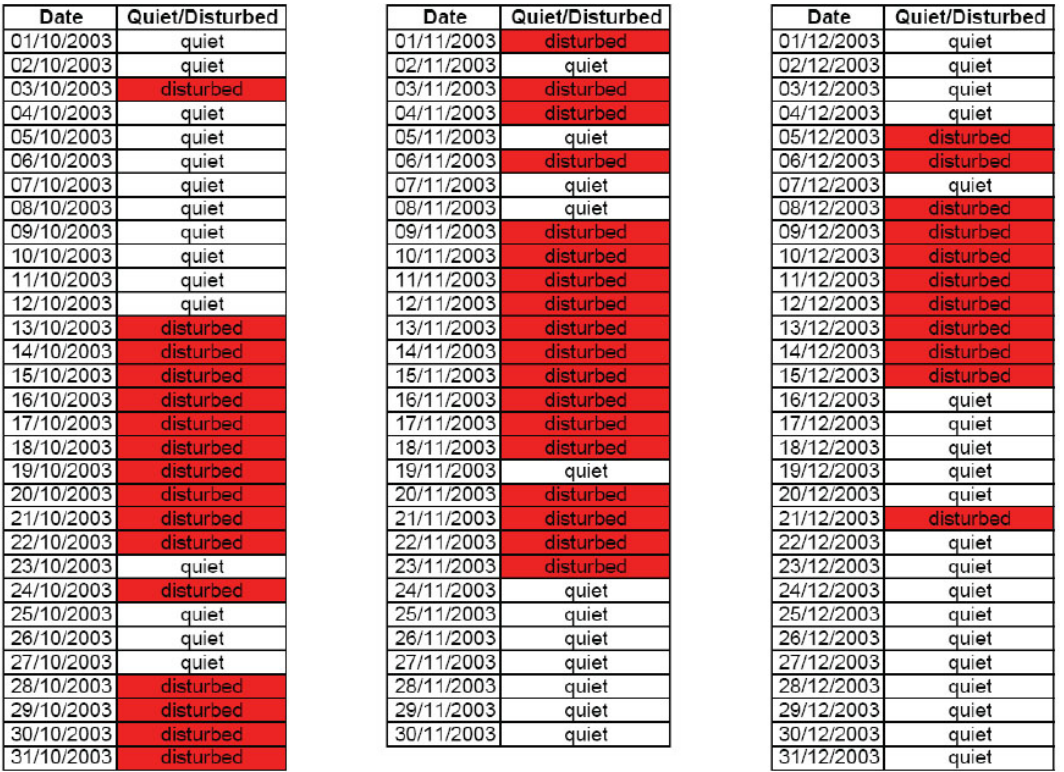
Fig. 3. List of days and their geomagnetic